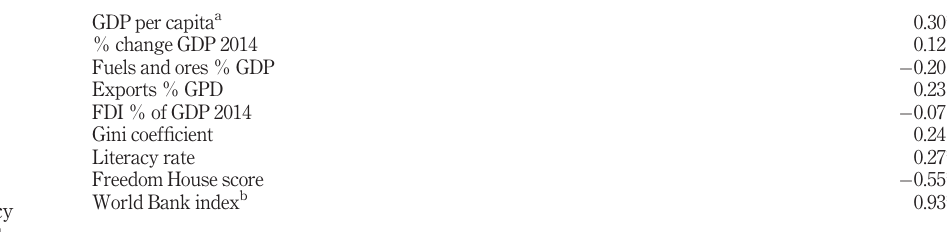
international corruption